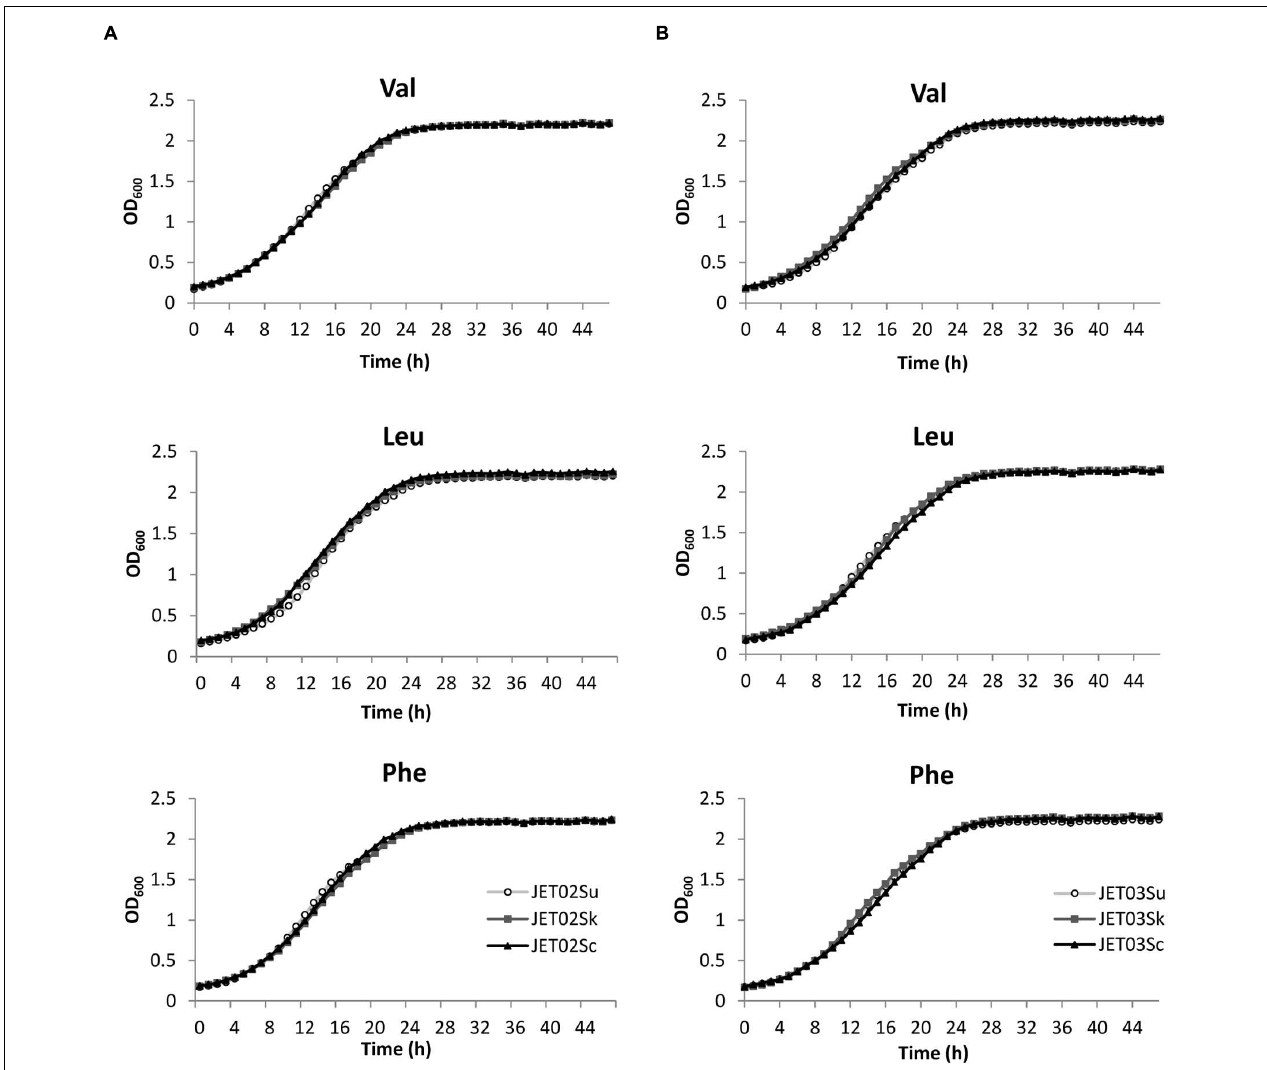
FIGURE 3 | Growth of the JET02-derived strains that harbored the individual ATF1 orthologs (A) and of the JET03-derived strains that harbored the individual ATF2 orthologs (B) with the indicated amino acids as the nitrogen source.